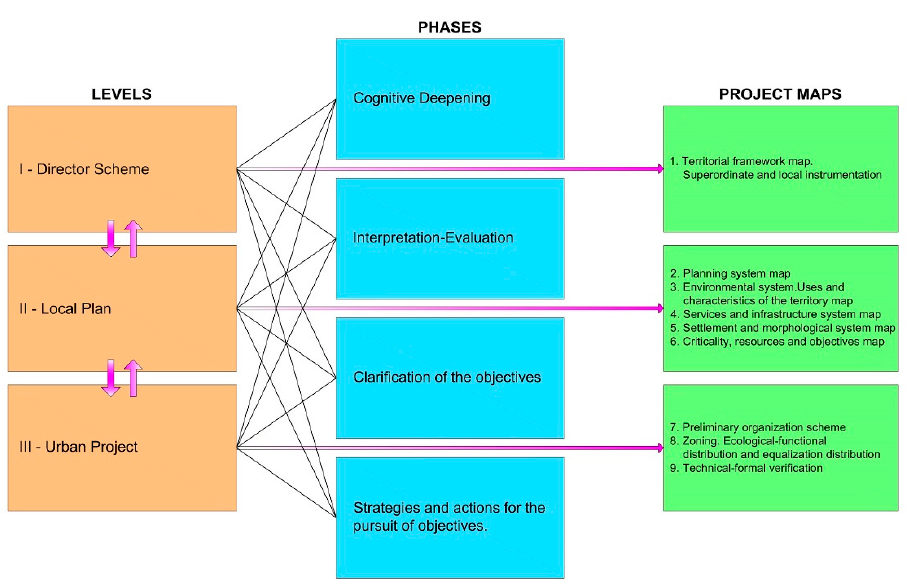
Figure 5. Methodological structure of the project. (Source: elaboration by author).